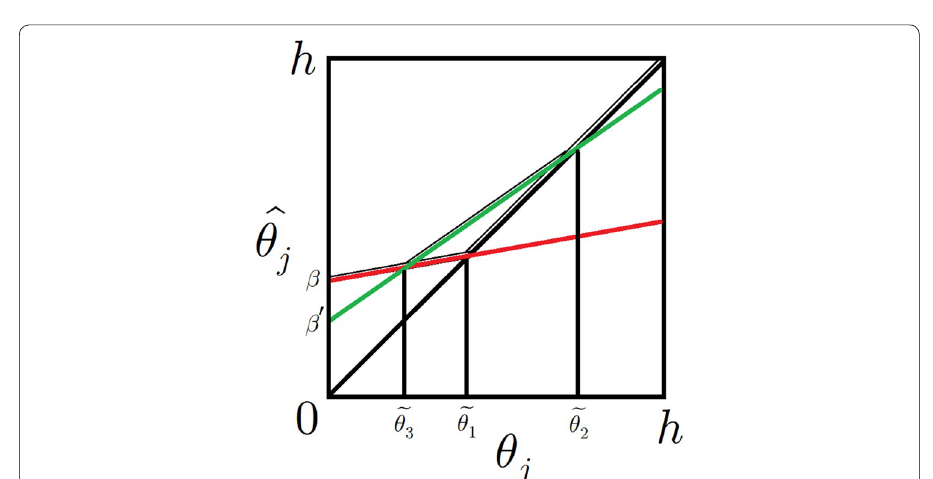
Fig. 5 Same as in Fig. 4. The only addition is the green line. Processing trade entails a little bit risk but guaran- tees better outcome than domestic imitation. That is why the slope is stiffer and the intercept is smaller than the red